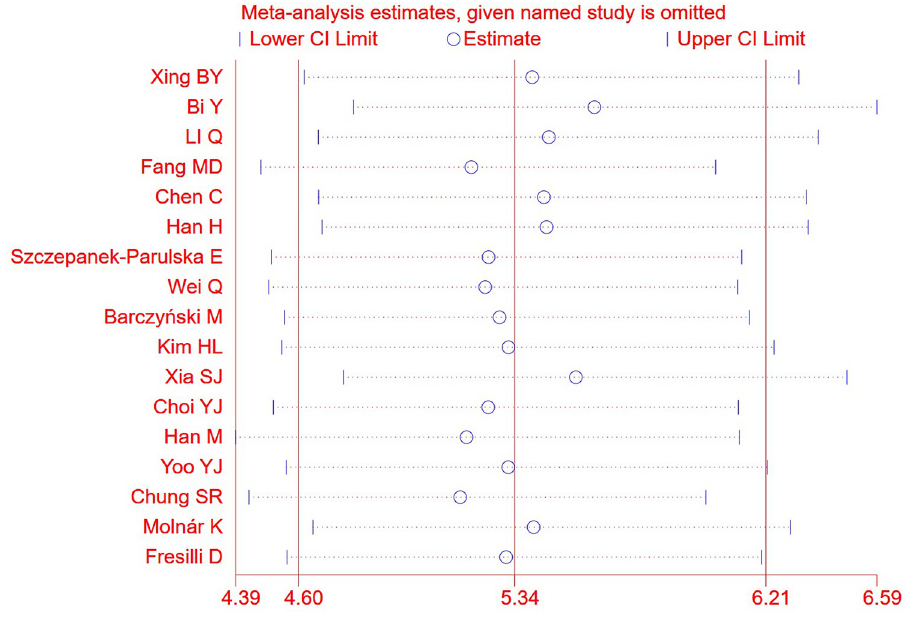
Fig 2. The sensitivity analysis carried out in this paper. They did not significantly affect the results.